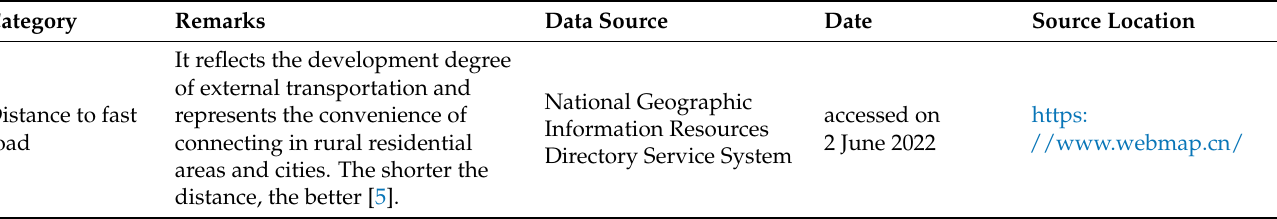
Table 1. Data and data